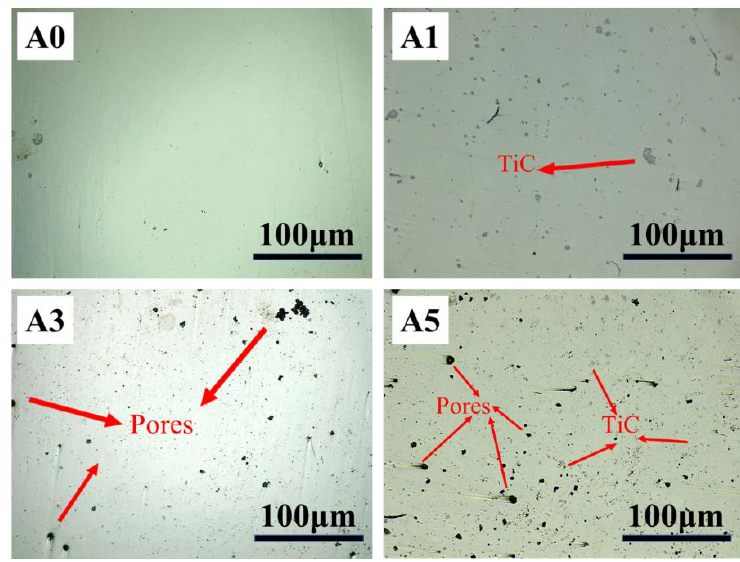
Figure 4. OM morphologies of the LPBF-printed TiC/M2HSS.